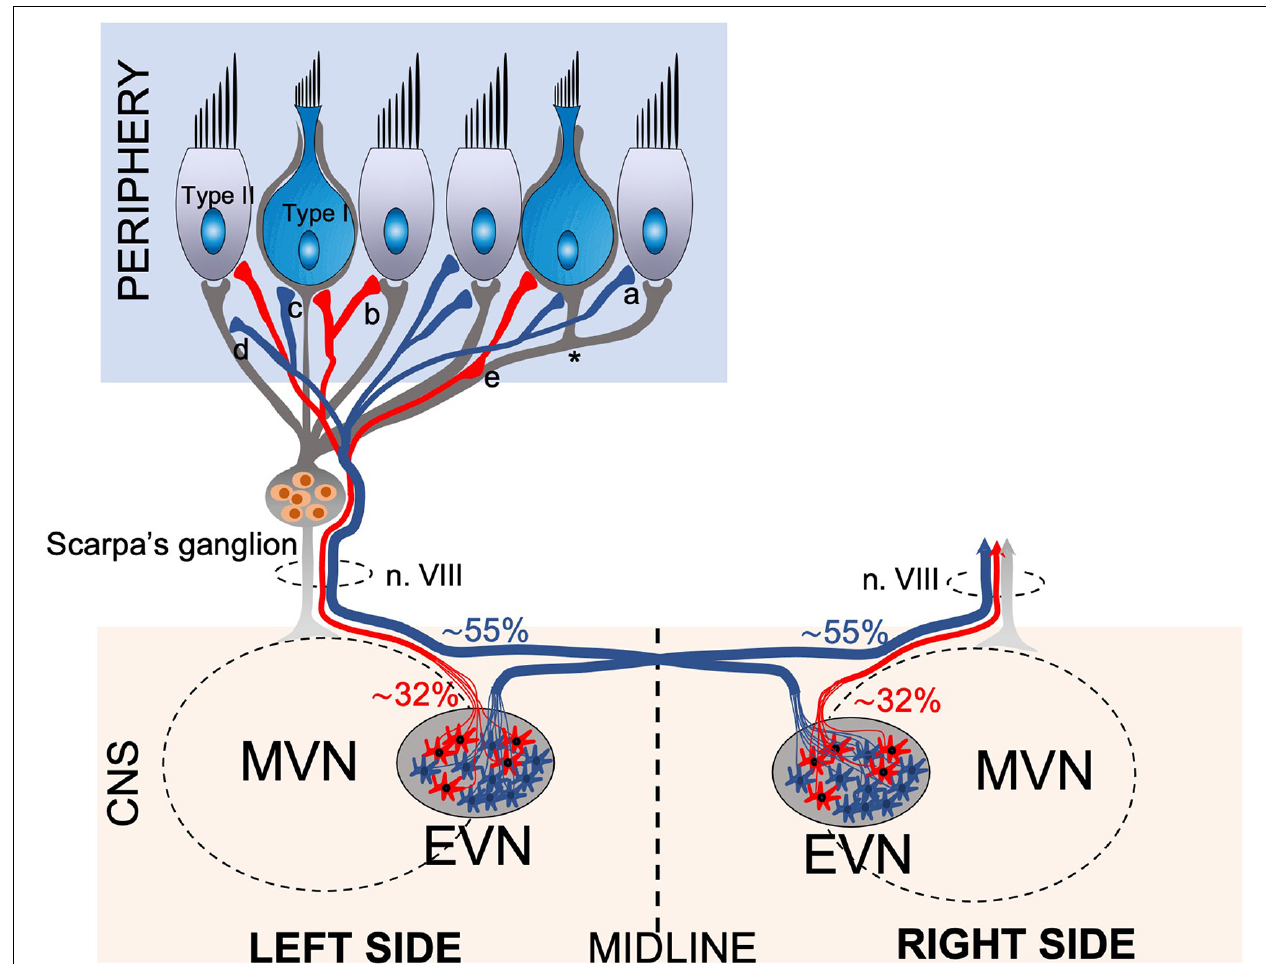
FIGURE 7 | Schematic drawing of the anatomical projections of the Efferent Vestibular System. Schematic of efferent (red, blue) and afferent (gray) innervation of the vestibular neuroepithelium, which consists of amphora shape Type I and cylindrical shape Type II hair cells. The afferent fibers originating from the bipolar neurons of Scarpa’s ganglion transmit the vestibular sensory information from the labyrinths to the Vestibular Nuclei Complex (VNC) in the brainstem. The afferent fibers terminate in bouton terminals on Type II hair cells, calyx terminals on Type I hair cells, and dimorphic terminals comprising a bouton and a calyx (*). The efferent vestibular system originates from the Efferent Vestibular Nucleus (EVN) located in the brainstem. The EVN axons join the afferent fibers and travel in the vestibulocochlear nerve (n. VIII) to the neuroepithelium. Efferent fibers make synaptic contacts to the outer surface of type II hair cells (a) , afferent boutons (b) , calyx terminals (c) , afferent fibers (d) , and en-passant synapsis formed by axonal varicosities to afferent fibers (e) . Approximately 55% of EVN neurons provide contralateral (opposite side) projections, the axons cross the midline and join the opposite side vestibulocochlear nerve, while approx. 32% of neurons project ipsilaterally (same